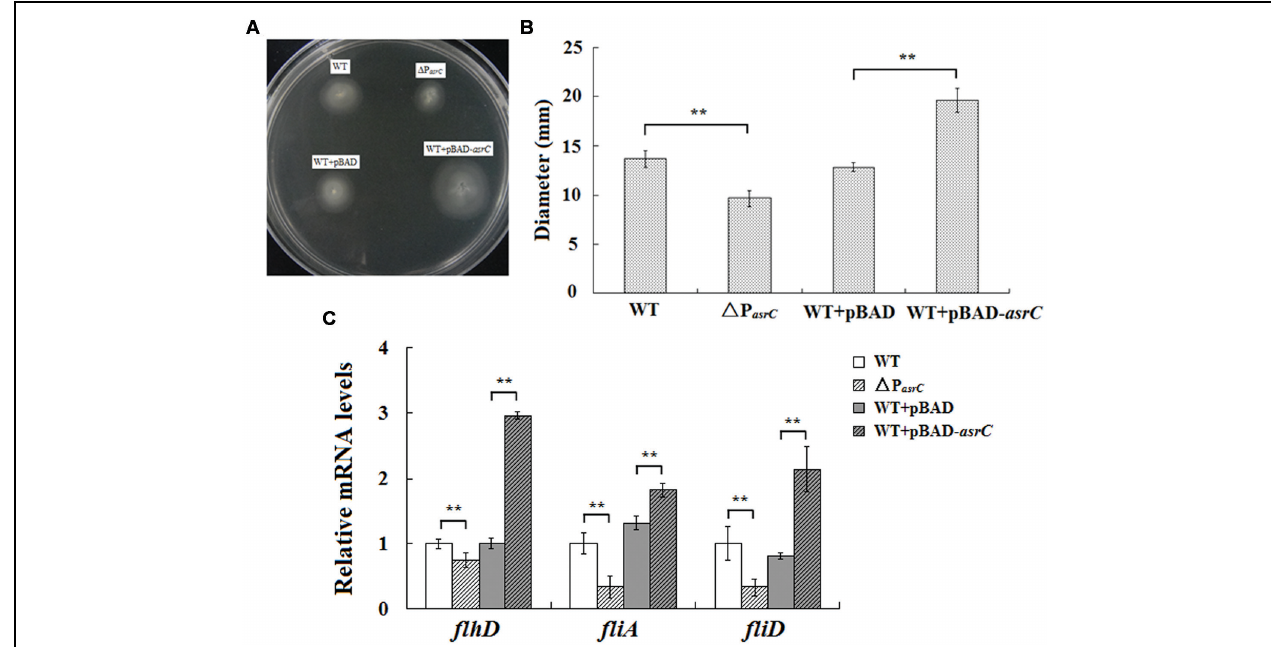
FIGURE 4 | Motility assay of the wild type, (cid:2) P asrC , WT + pBAD and WT + pBAD- asrC strains. (A) AsrC-promoter mutant strain with decreased motility. Overexpression of AsrC increased motility on swim-agar plates. (B) Motility ring diameters of S. typhi strains. Bacterial were spotted onto LB plates with 0.3% agar and incubated at 37 ◦ C for 8 h. The image is representative of three independent experiments. (C) mRNA of flagellar genes ( flhD , fliA, and fliD ) determined by qRT-PCR. RNA was extracted from three independent cultures for each strain grown to OD 600 0.4. Levels of 5S rRNA were the internal reference. ∗∗ P < 0.01 compared with control group.